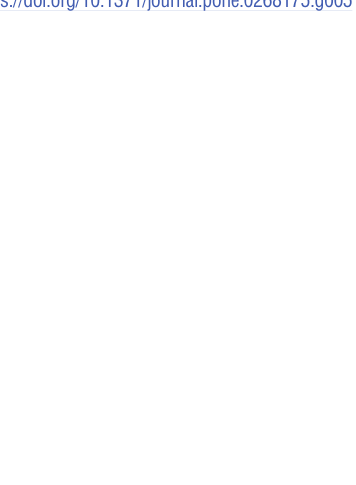
Fig 5. Cladogram of soil fungal populations in different soil samples. The linear discriminant analysis score was 4.0.